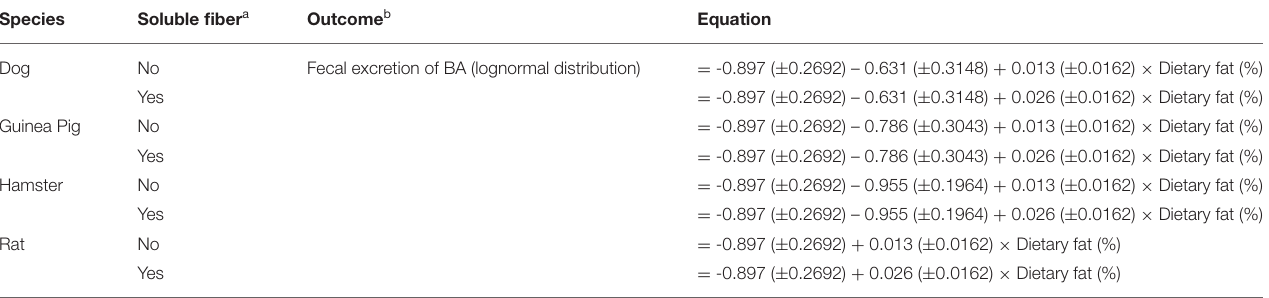
TABLE 8 | Fat model equations for total fecal bile acids excretion. Species